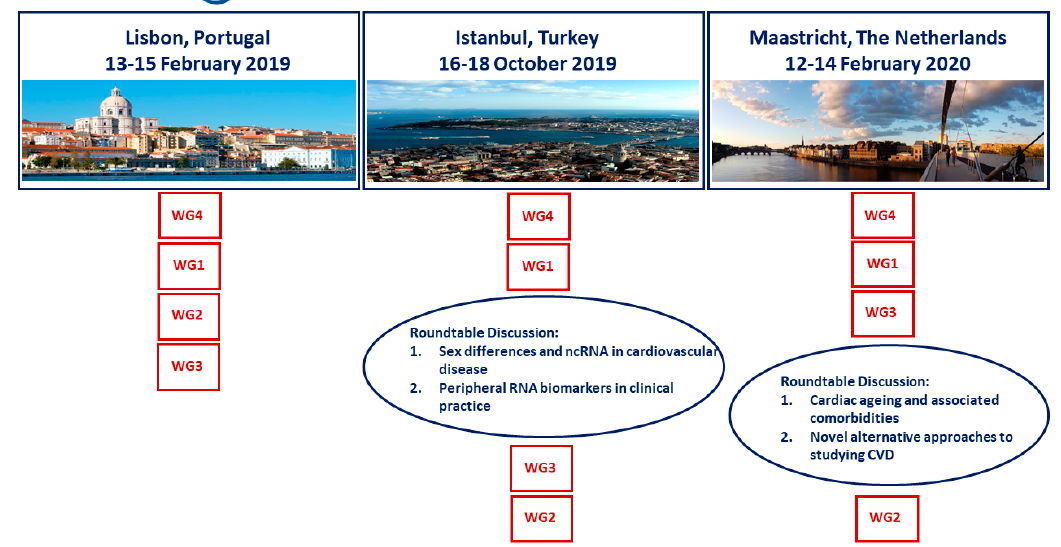
Figure 1. EU-CardioRNA Working Group organisation .